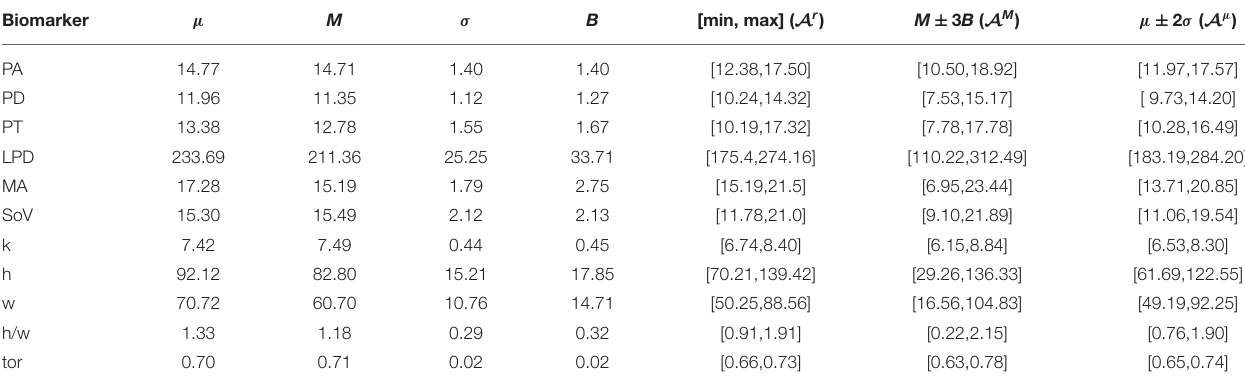
TABLE 2 | Statistical description of each one of the biomarkers measured on the aorta.